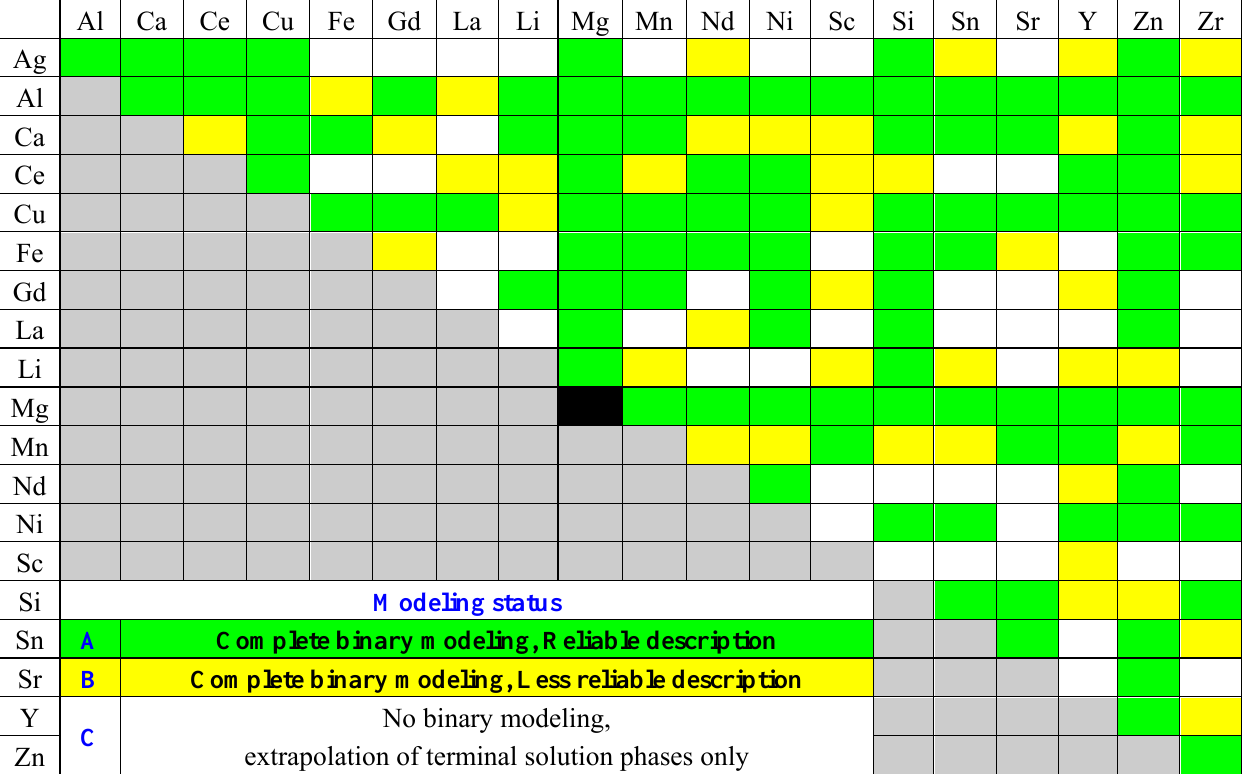
Table 1. Classification of the modeling status of basic binary